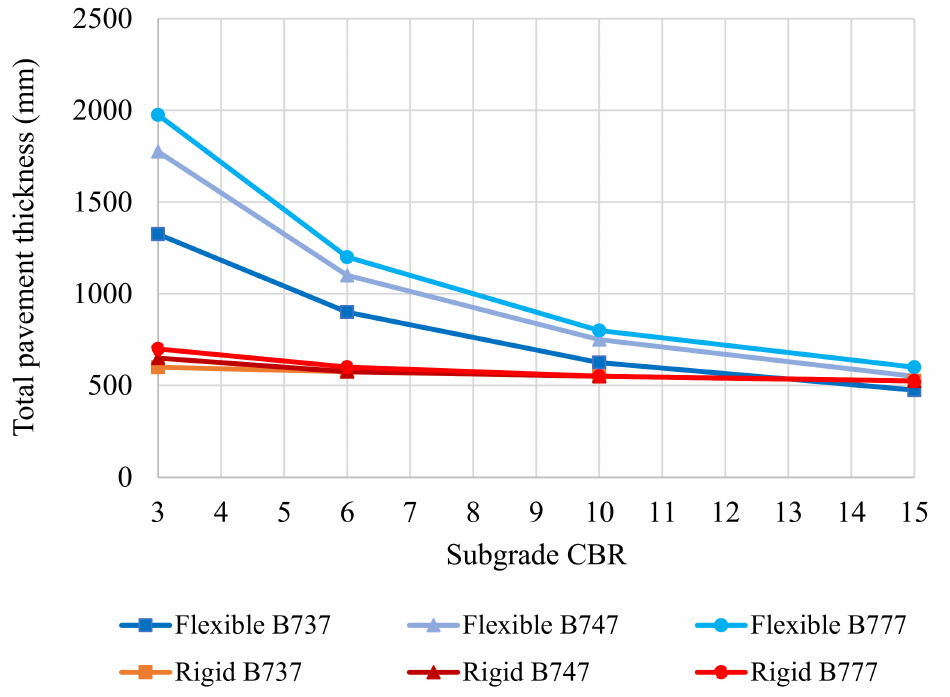
Figure 2. Subgrade CBR effect on total pavement